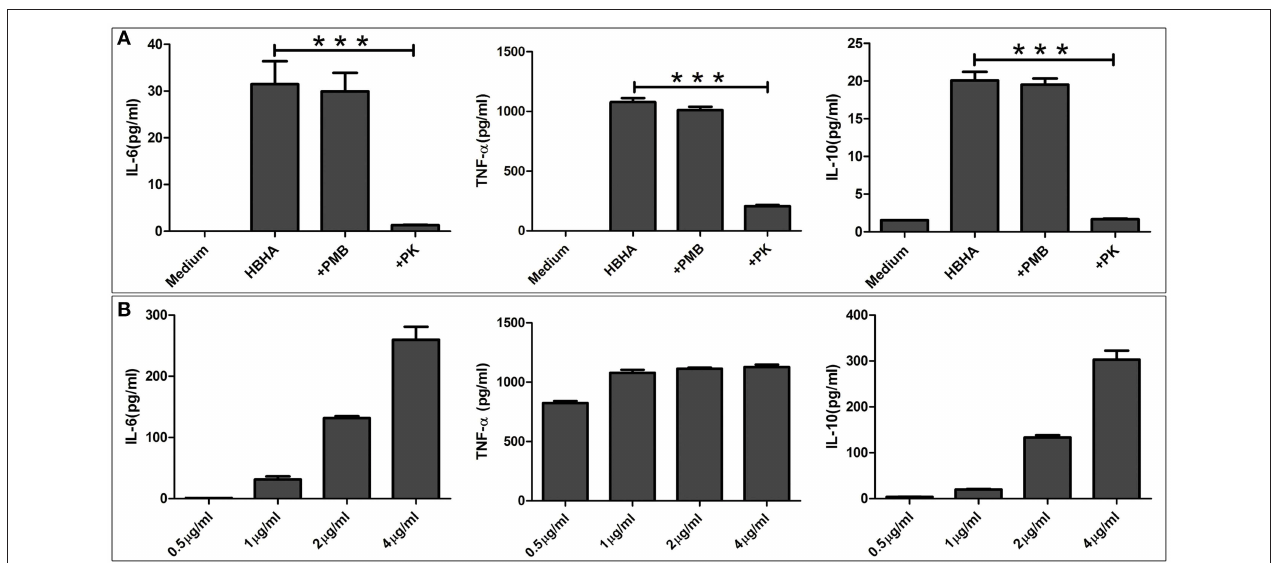
FIGURE 6 | HBHA induces interleukin-6 (IL-6), tumor necrosis factor- α (TNF- α ), and IL-10 production in RAW264.7 cells. (A) RAW264.7 cells were stimulated with HBHA (1 µ g/ml) for 18h at 37 ◦ C, and the cytokines from culture supernatants were measured by ELISA. To exclude the possibility that lipopolysaccharide (LPS) contaminated the recombinant protein, HBHA was pretreated with an inhibitor of LPS, polymyxin B ( + PMB). To confirm that the activation of RAW264.7 cells was attributed to HBHA, the protein (1 µ g/ml) was pretreated with proteinase K. IL-6, TNF- α , and IL-10 in the culture supernatants was measured at 18h. Data are expressed as the mean ± SD from three separate experiments. *** P < 0.001. (B) RAW264.7 cells were cultured with various concentrations of HBHA (0.5, 1, 2, or 4 µ g/ml). Cell culture supernatants were collected at 18h, and the levels of IL-6, TNF- α , and IL-10 were detected with ELISA.